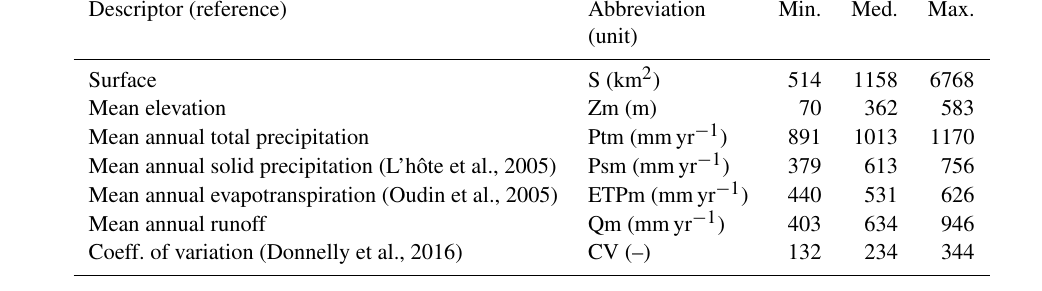
Table 3. Main characteristics of the 30 catchments. Mean annual values and the coefficient of variation were computed over 1995–2016.